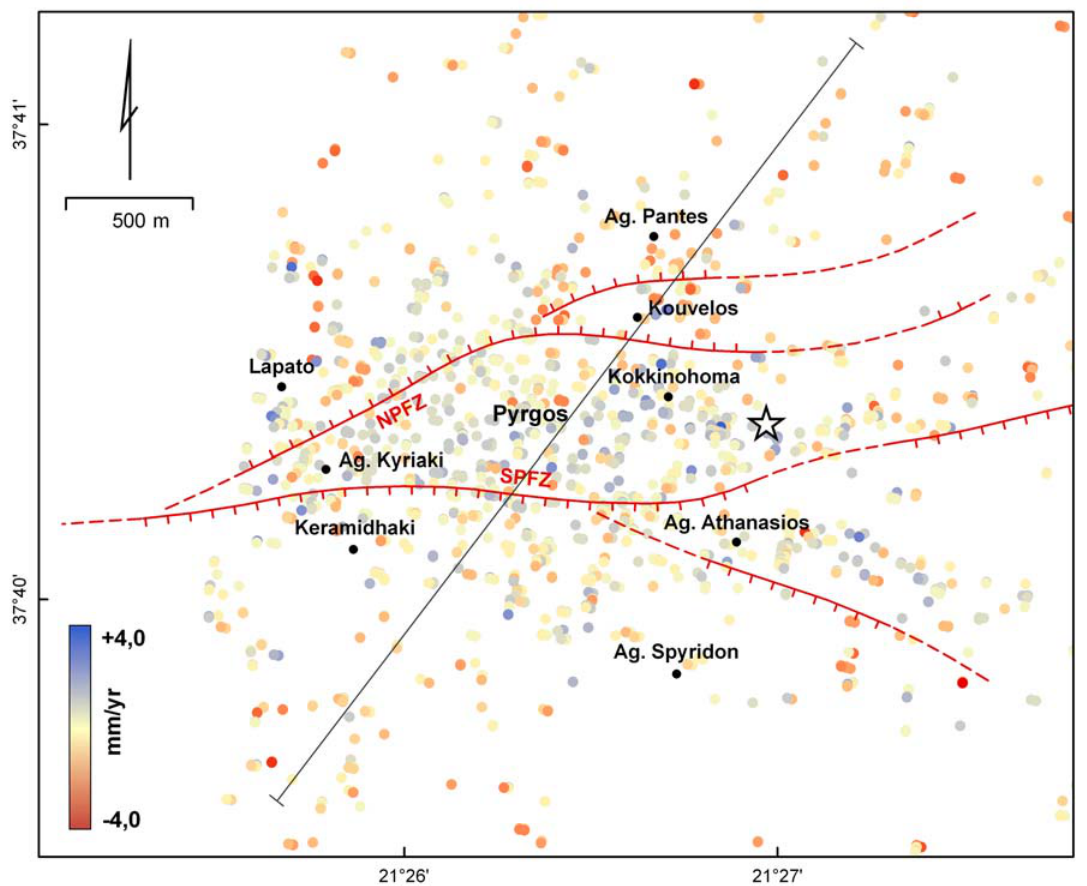
Figure 9. Point targets plotted over the fault map of Pyrgos area, solid line corresponds to the section of Figure